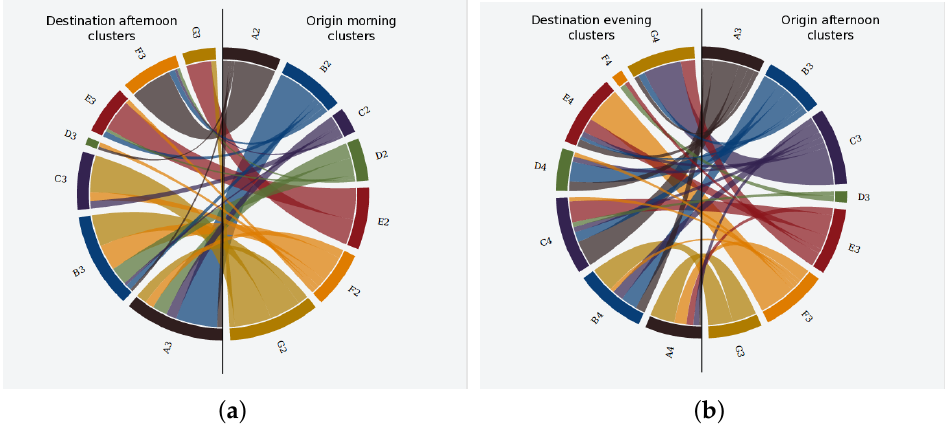
Figure 11. Mobility patterns for NY dataset. ( a ) transition from morning to afternoon clusters; ( b ) transition from afternoon to evening